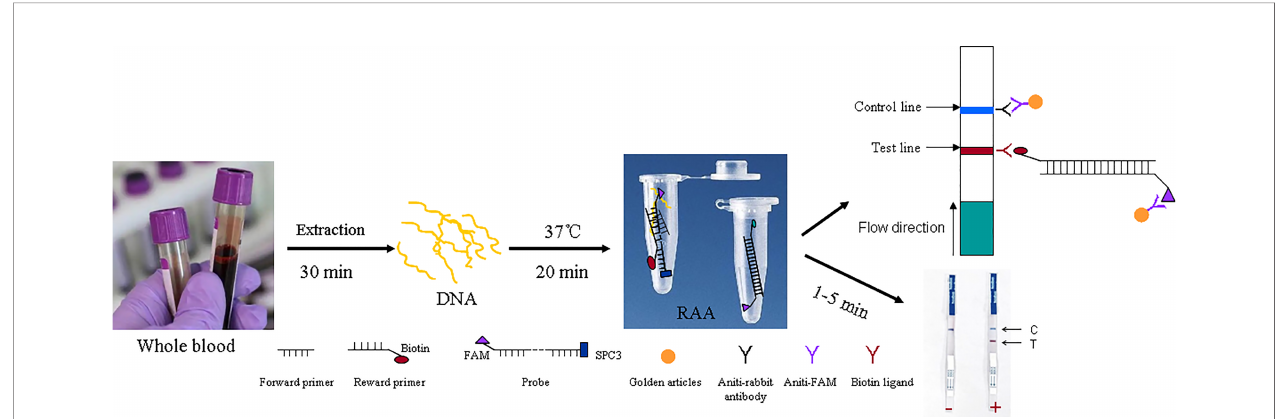
FIGURE 1 | Flow chat of RAA-LFD. All work fi nish within 1